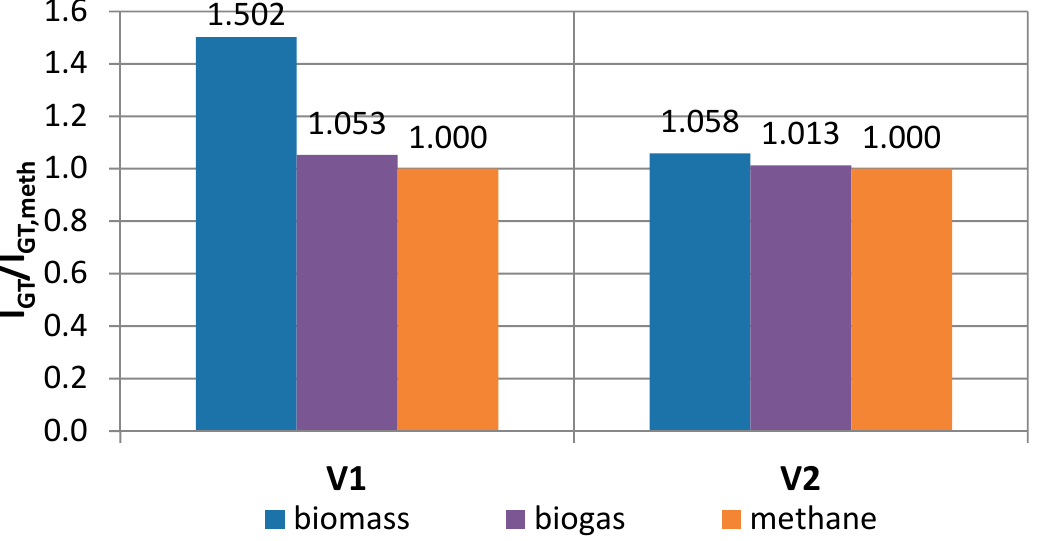
Figure 9. The influence of the structure of the cycle and calorific value of fuel for both variants on the effective power related to that with methane as a fuel.